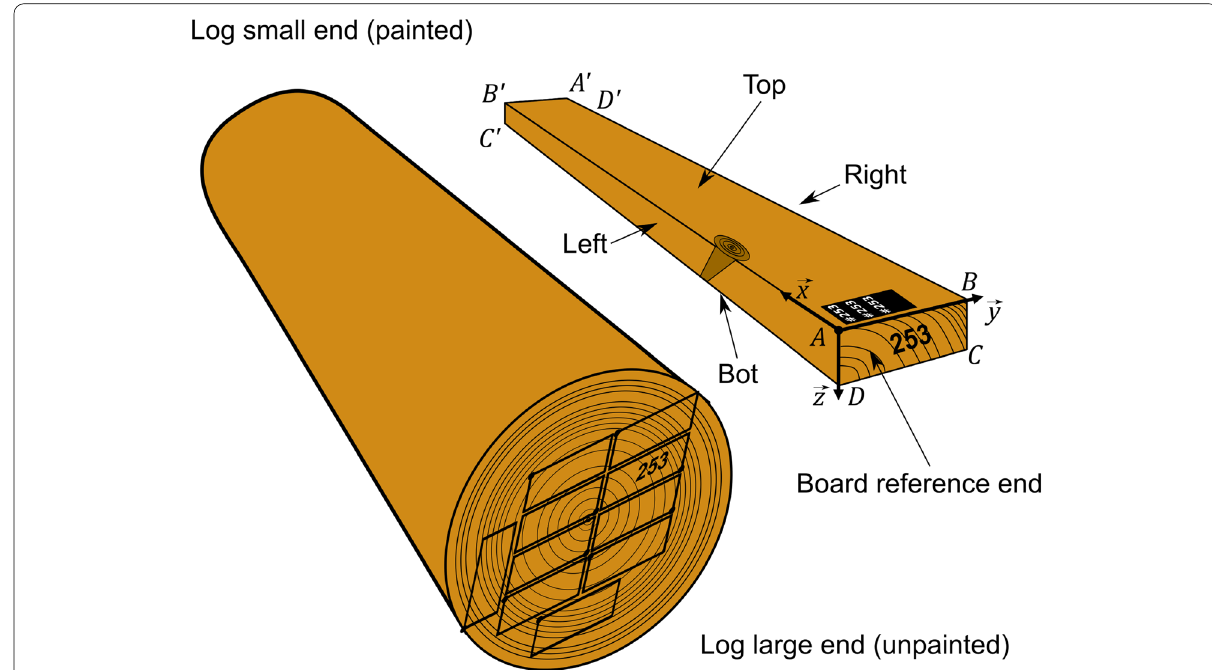
Fig. 7 Schematic representation of a board with its relative coordinate system and corresponding position in the log